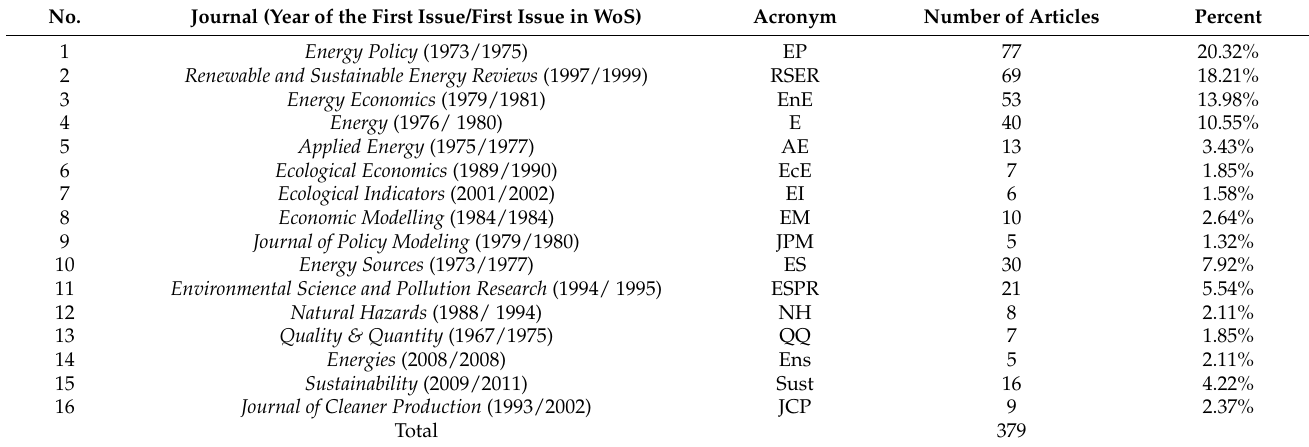
Table 2. Breakdown of identified articles by source journal.